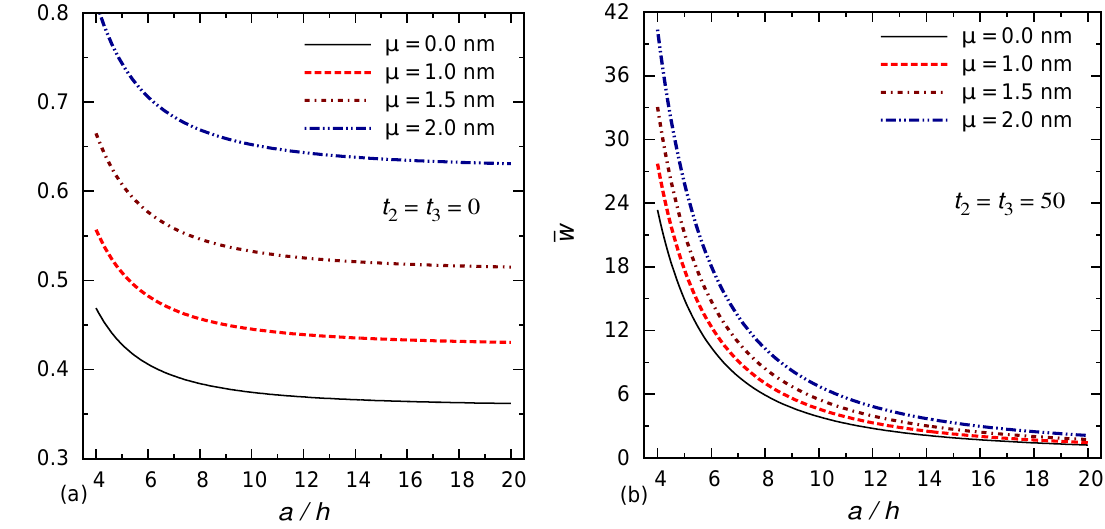
Figure 4. Effects of the nonlocal coefficient and thermal loads versus the side-to-thickness ratio a / h on the deflection ¯ w of the FG square nanoplates embedded in Winkler elastic medium ( a ) t 2 = t 3 = 0 and ( b ) t 2 = t 3 = 50 ( z / h = 0, κ 1 = 10, κ 2 = 0 )